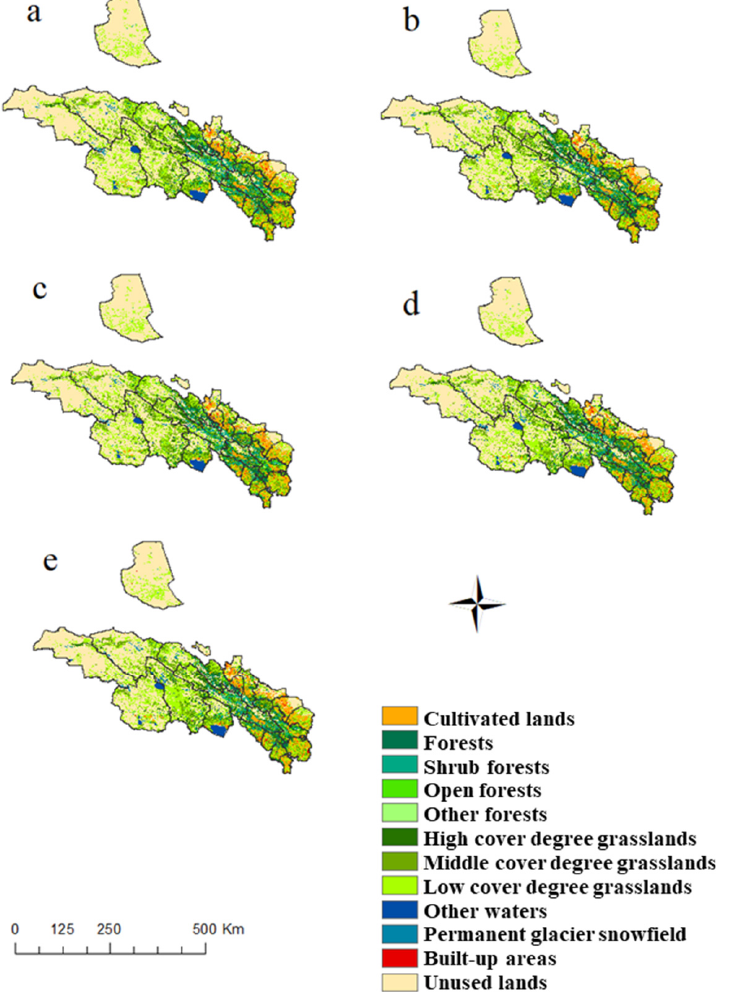
Figure 3. Types of land use in the Qilian Mountains in 1990 ( a ), 2000 ( b ), 2005 ( c ), 2010 ( d ), and 2015 ( e ).